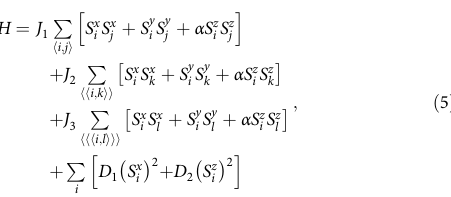
of parameters: J 1 = 3.18 meV, J 2 = 4.82meV, J 3 = 9.08meV, α = 0.66, D 1 = − 0.89 meV, D 2 = 2.85meV, we calculated single magnon dispersion and then two- magnon continuum with the kinematic constraints. See Supplementary Informa- tion for further details.